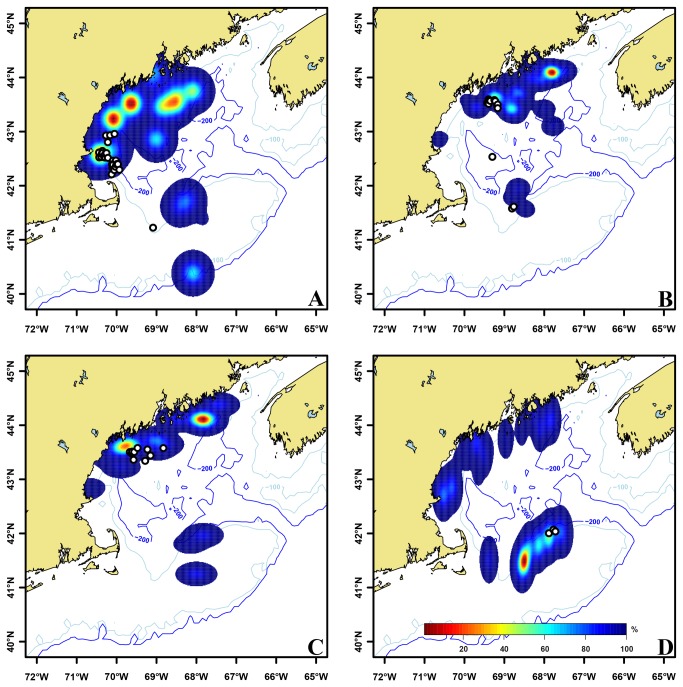
Spatial relationship between Atlantic herring and Atlantic bluefin tuna in the Gulf of Maine.Atlantic herring kernel density estimations were constructed based on the metric tons of herring captured in each tow or set (trawler or purse seiner, respectively). Density estimations were normalized yielding utilization distributions that displayed probability of occurrence during four two week time periods, A) June 1-15 1997, B) August 16-30 2003, C) July 16-31 2004, and August 1-15 2005. Atlantic bluefin tuna (white circles with solid black borders) were located closer to high probability regions of Atlantic herring than a randomly distributed population. While the majority of bluefin tuna schools were located within areas of high herring probability, some schools of bluefin tuna did not display any association with herring.